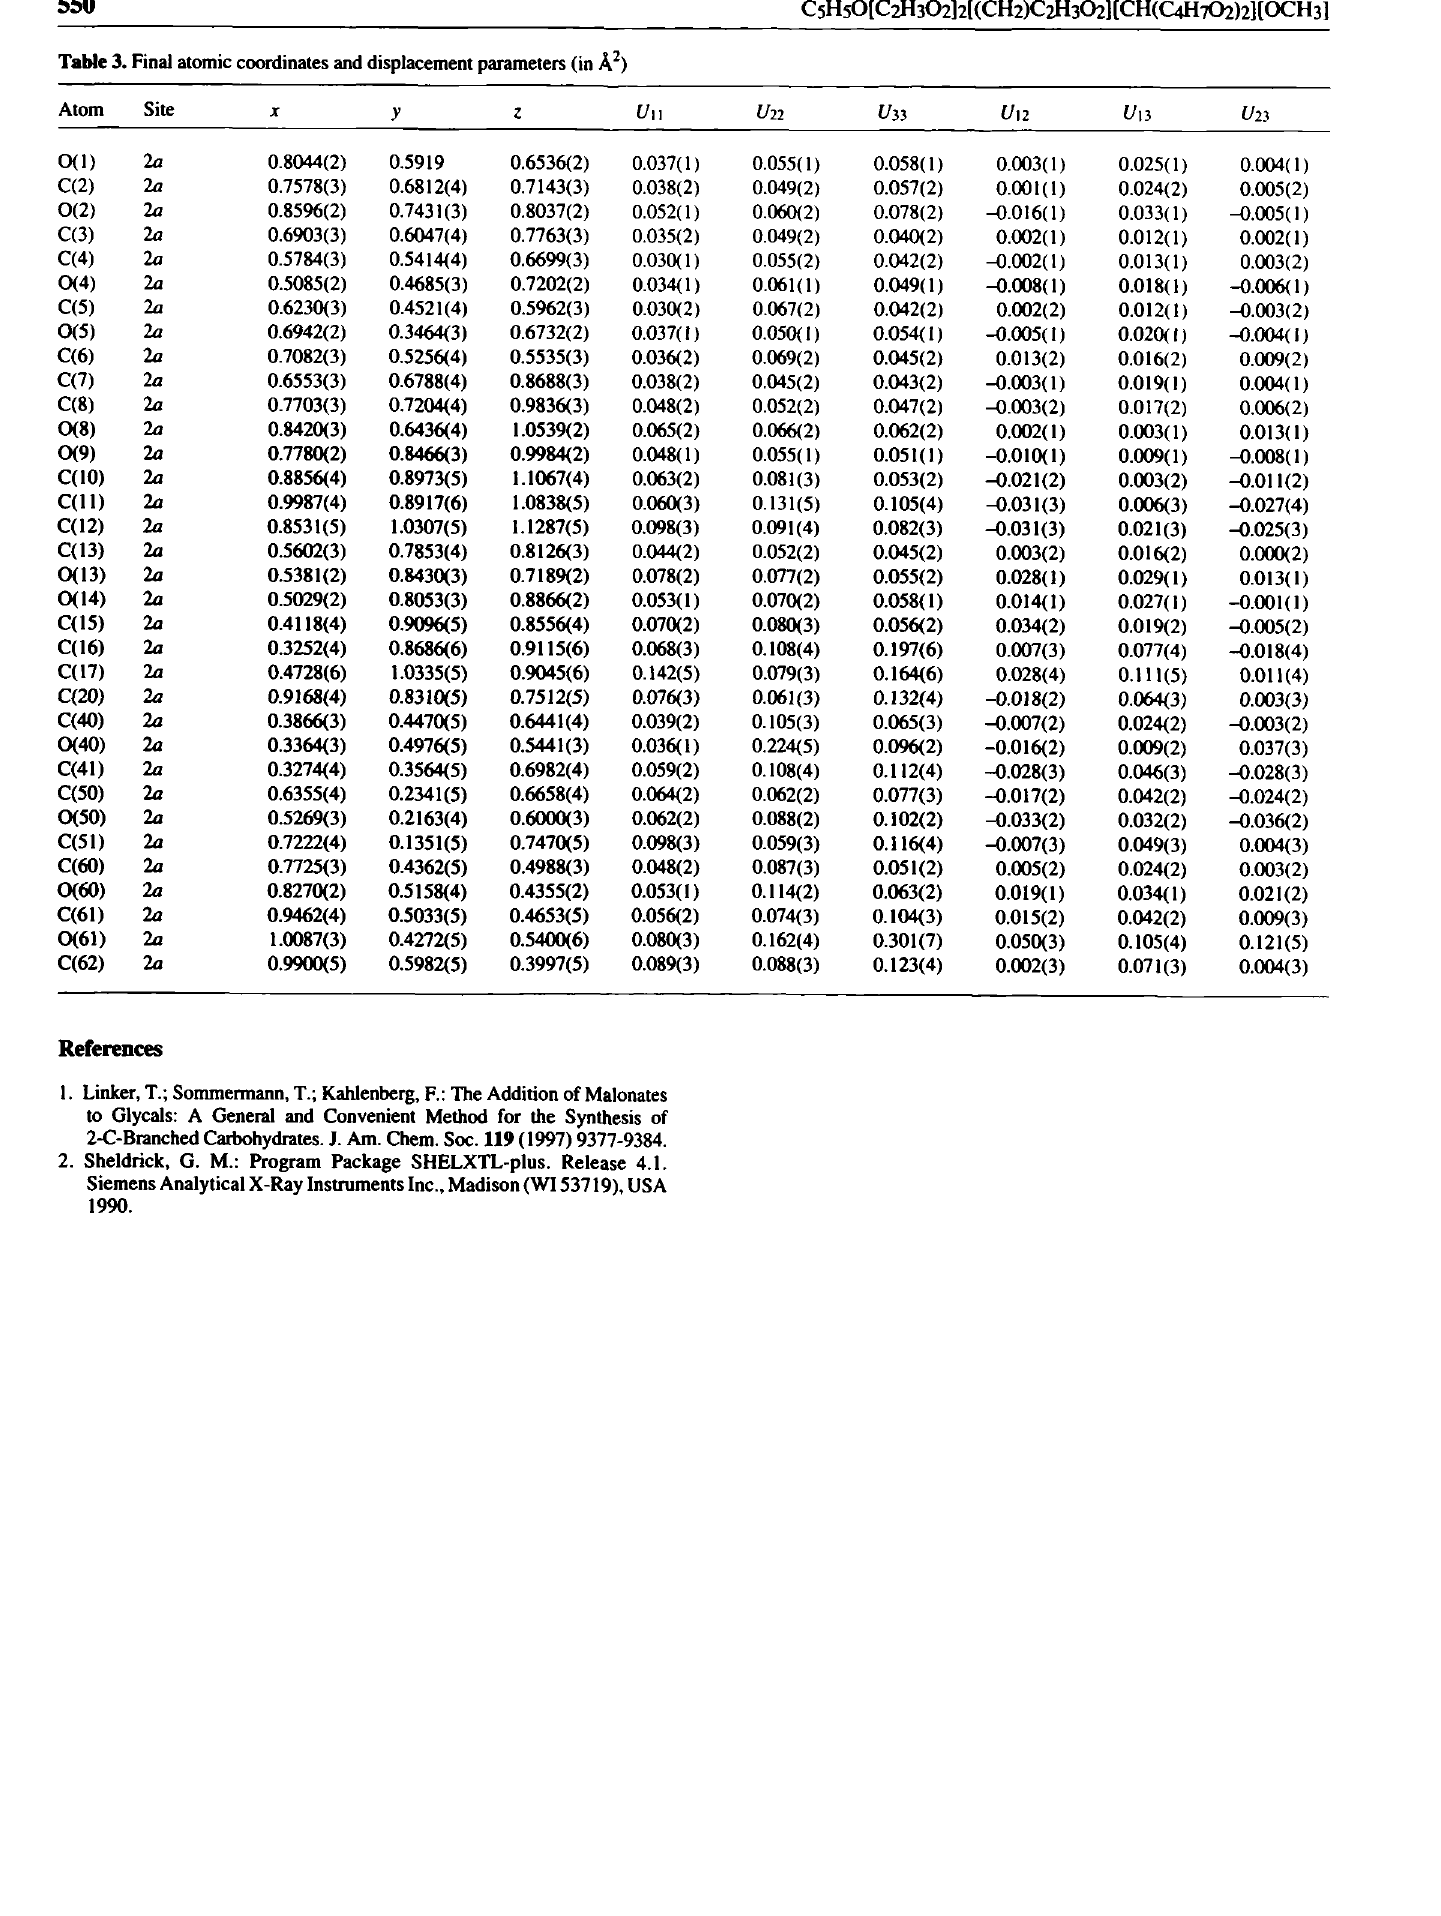
Table 3. Final atomic coordinates and displacement parameters (in